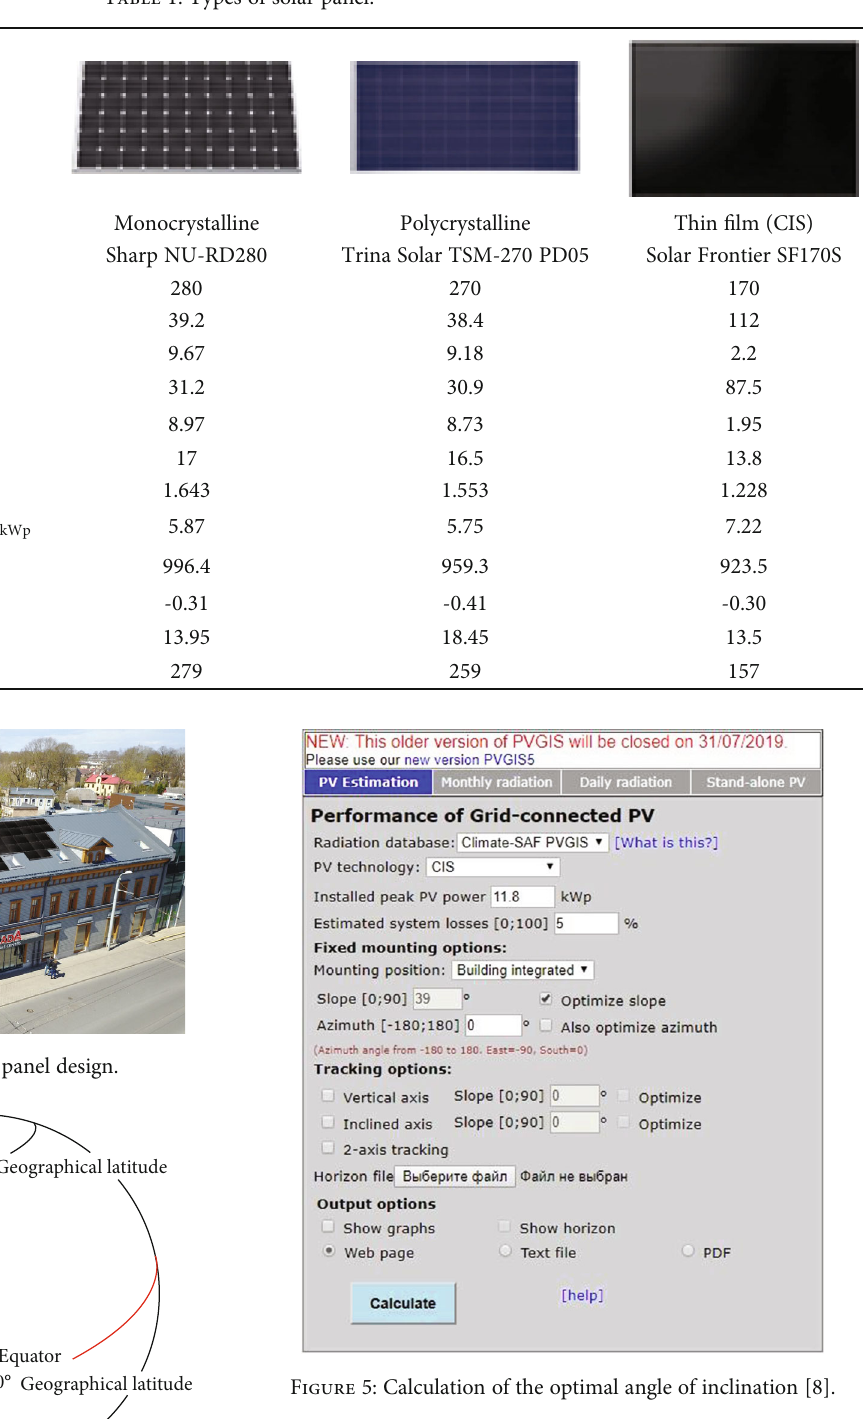
Table 1: Types of solar panel.